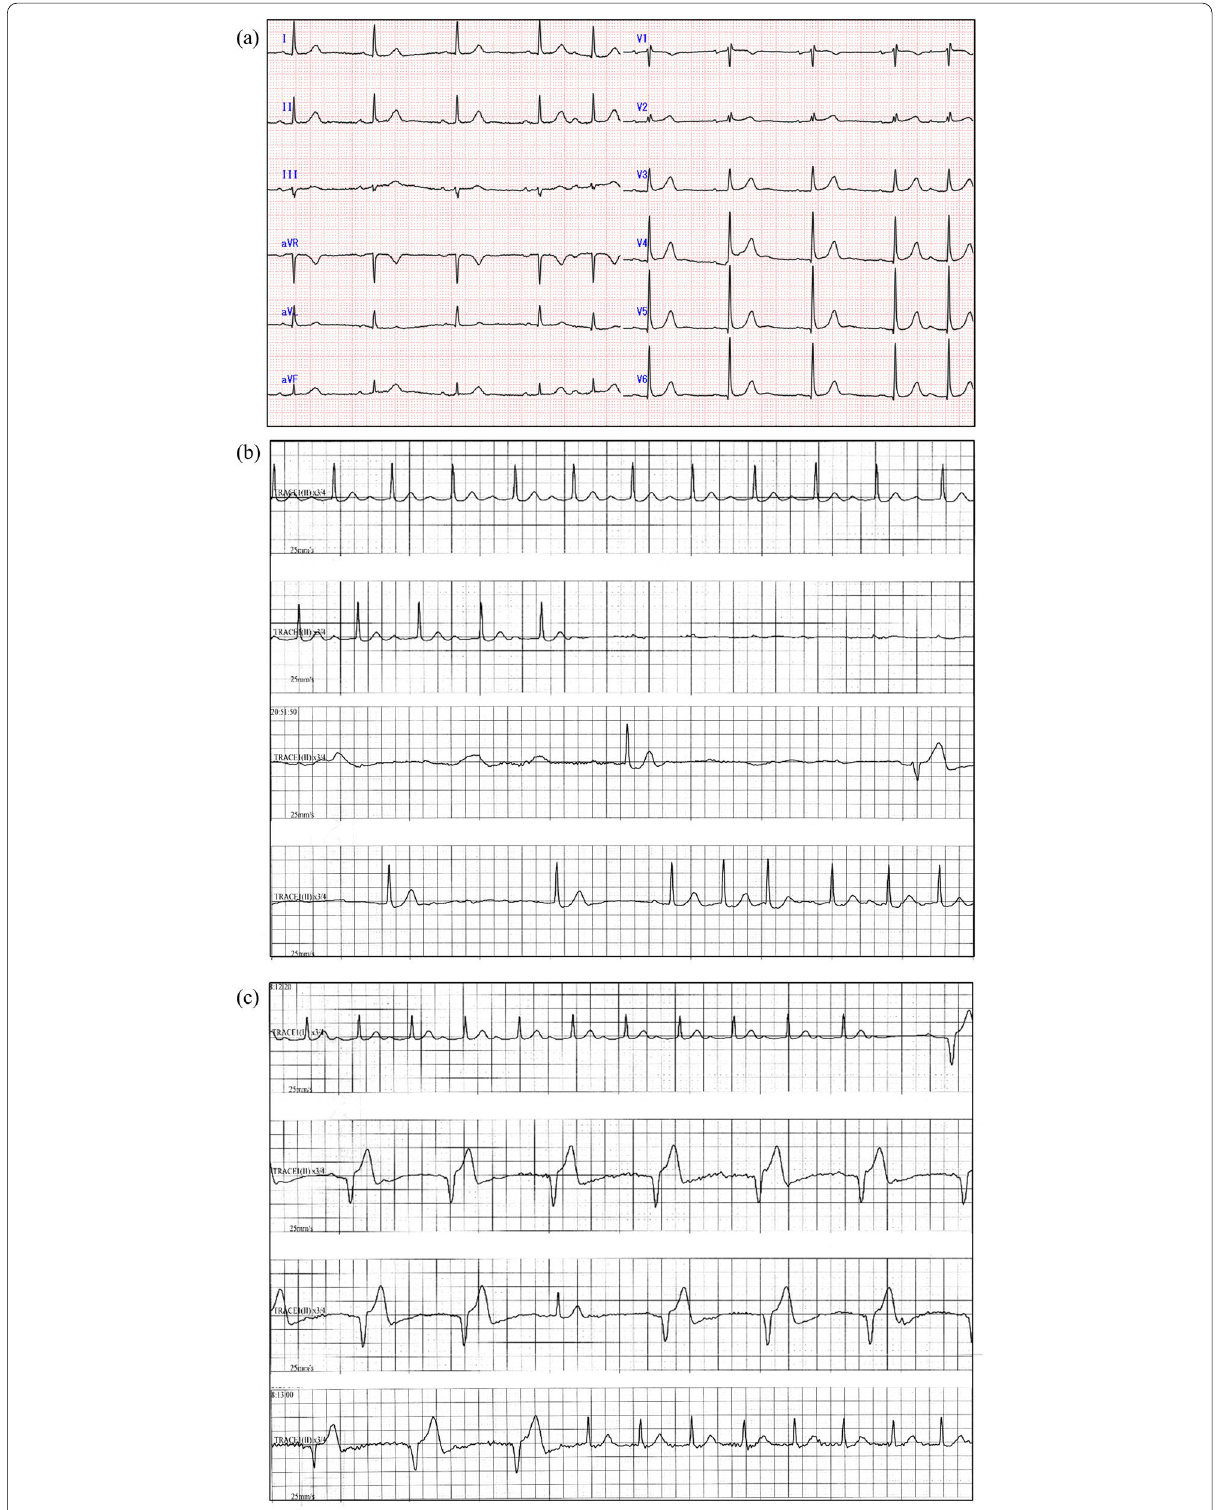
Fig. 1 Electrocardiogram before anesthesia ( a ), at 9 h postoperatively in II lead ( b ), and after implantation of a temporary pacemaker in II lead ( c ). a First-degree atrioventricular block (AVB). b Complete AVB lasted for 10 s (and recovered without treatment). c Pacemaker-generated waves (40 per min) after the absence of QRS complex for 4